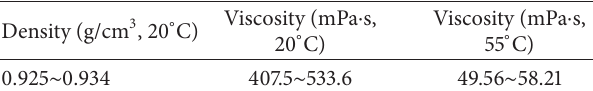
Table 3: Characteristics of crude oil under surface conditions.